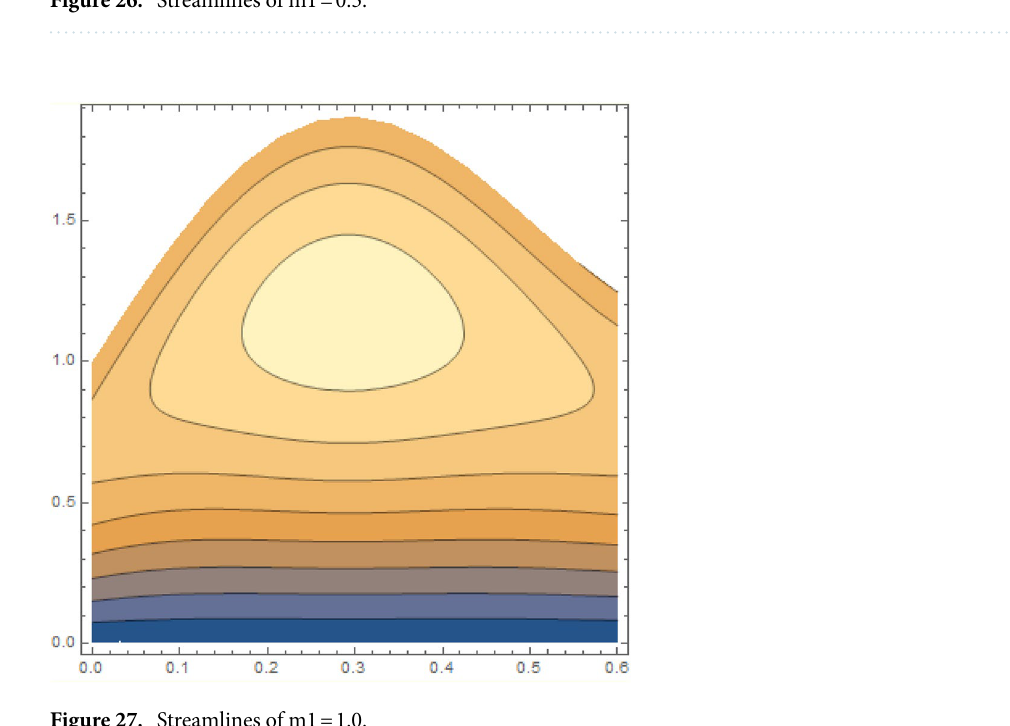
Figure 26. Streamlines of m1 = 0.5.